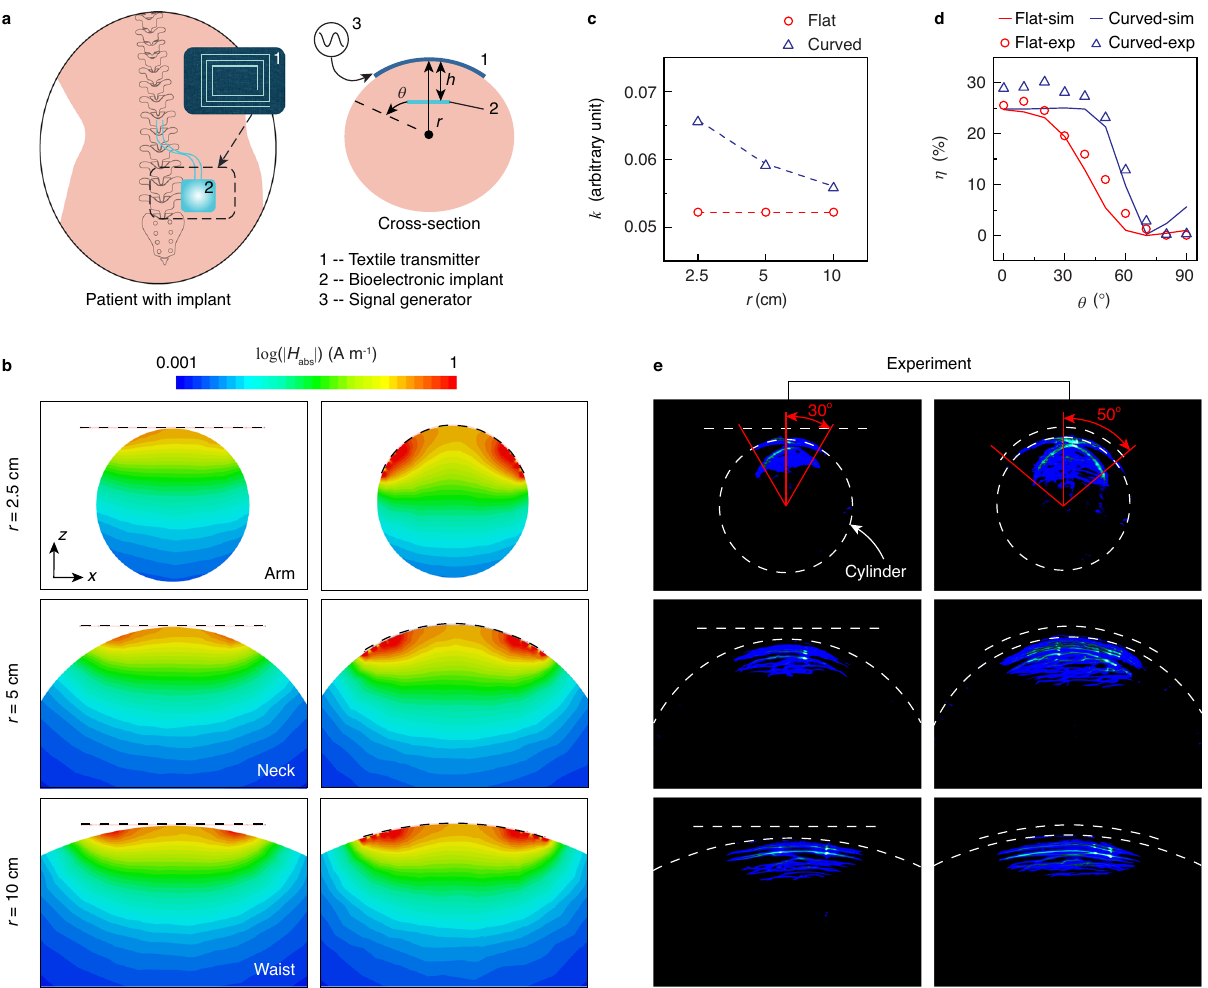
Fig. 3 Textile wireless power transmitters for implants. a Illustration of a textile transmitter being used to wirelessly power a bioelectronic implant. The cross-section view shows the radius of curvature r , device depth h , and alignment angle θ . The transmitter is connected to a signal generator, which can be integrated in a wearable form factor. b Cross-section view of simulated magnetic fi eld ∣ H abs ∣ generated by a fl at and conformal transmitter placed on arm, neck and waist. Dotted black lines show the transmitter position. c Coupling coef fi cient k between fl at or conformal transmitters and a receiver placed at h = 1 cm, θ = 0°. d Corresponding wireless power transfer ef fi ciency η as a function of θ for r = 2.5 cm based on simulation and experimental measurement. e Long-exposure images of the body phantoms (1× PBS inside acrylic cylinders with r = 2.5, 5 and 10 cm) where position of the receiver is scanned inside. The receiver is con fi gured with a blue light-emitting diode (LED) that activates when suf fi cient power is transferred. The input power of the liquid metal textile transmitter is 20 dBm. Source data are provided as a Source Data fi